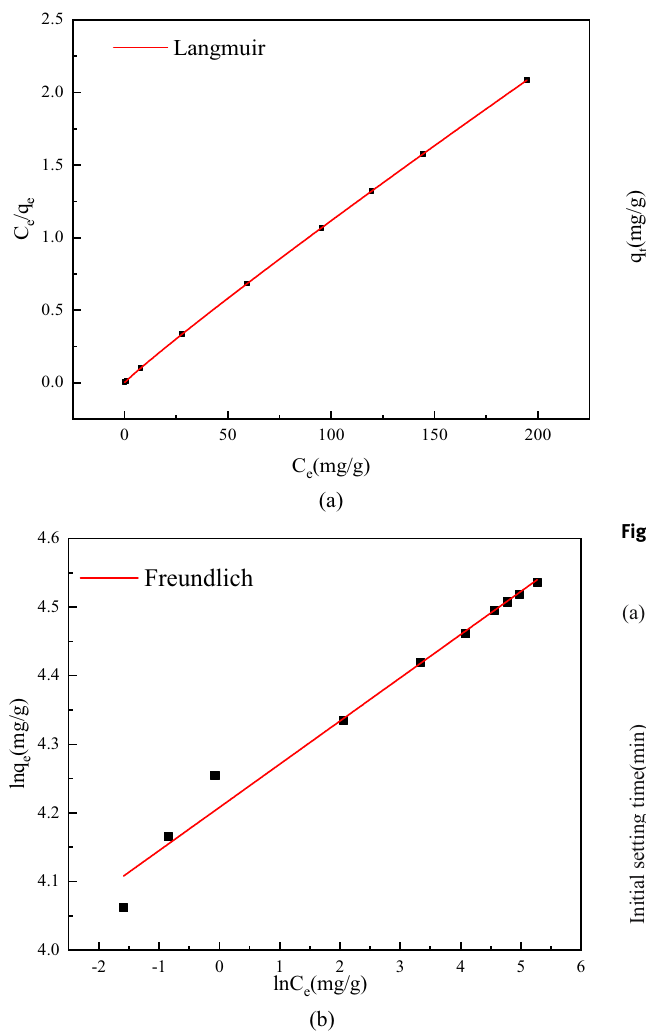
Figure 2: Adsorption isotherm experiment of Mg – Al - LDH: ( a ) Langmuir and ( b ) Freundlich.